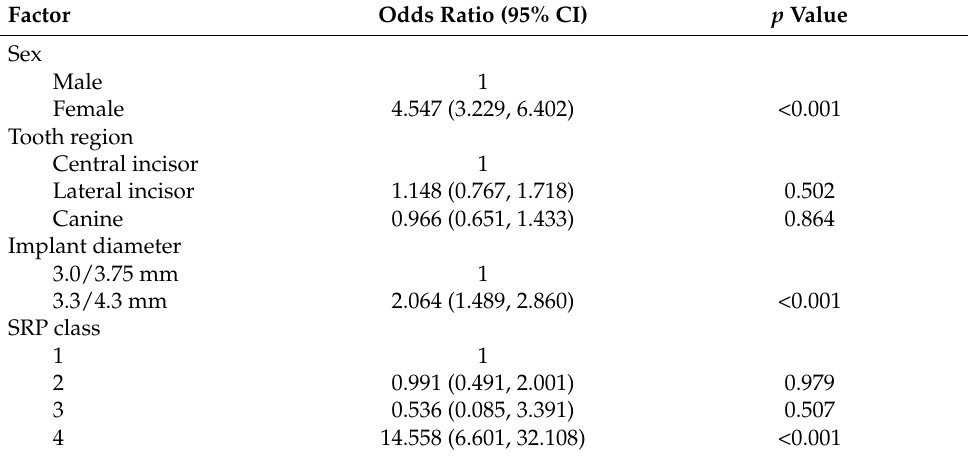
Table 8. Multivariate binary logistic regression model for cortical bone perforation or invasion of the 2 mm secure distance from the surrounding anatomical structures (in relation to no perforation), for bone-driven implant